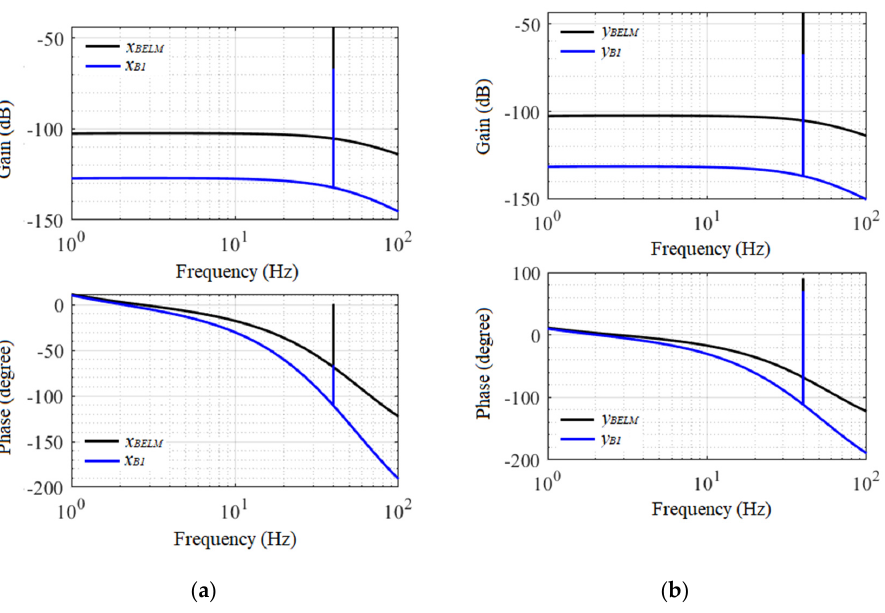
Figure 5. Simulated frequency responses of the BELM rotor and Bearing 1. ( a ) Simulated frequency responses of the BELM rotor and Bearing 1 in the X -direction; ( b ) Simulated frequency responses of the BELM rotor and Bearing 1 in the Y -direction. Table 4. Assumed and estimated stiffness and damping parameters of the two bearings.